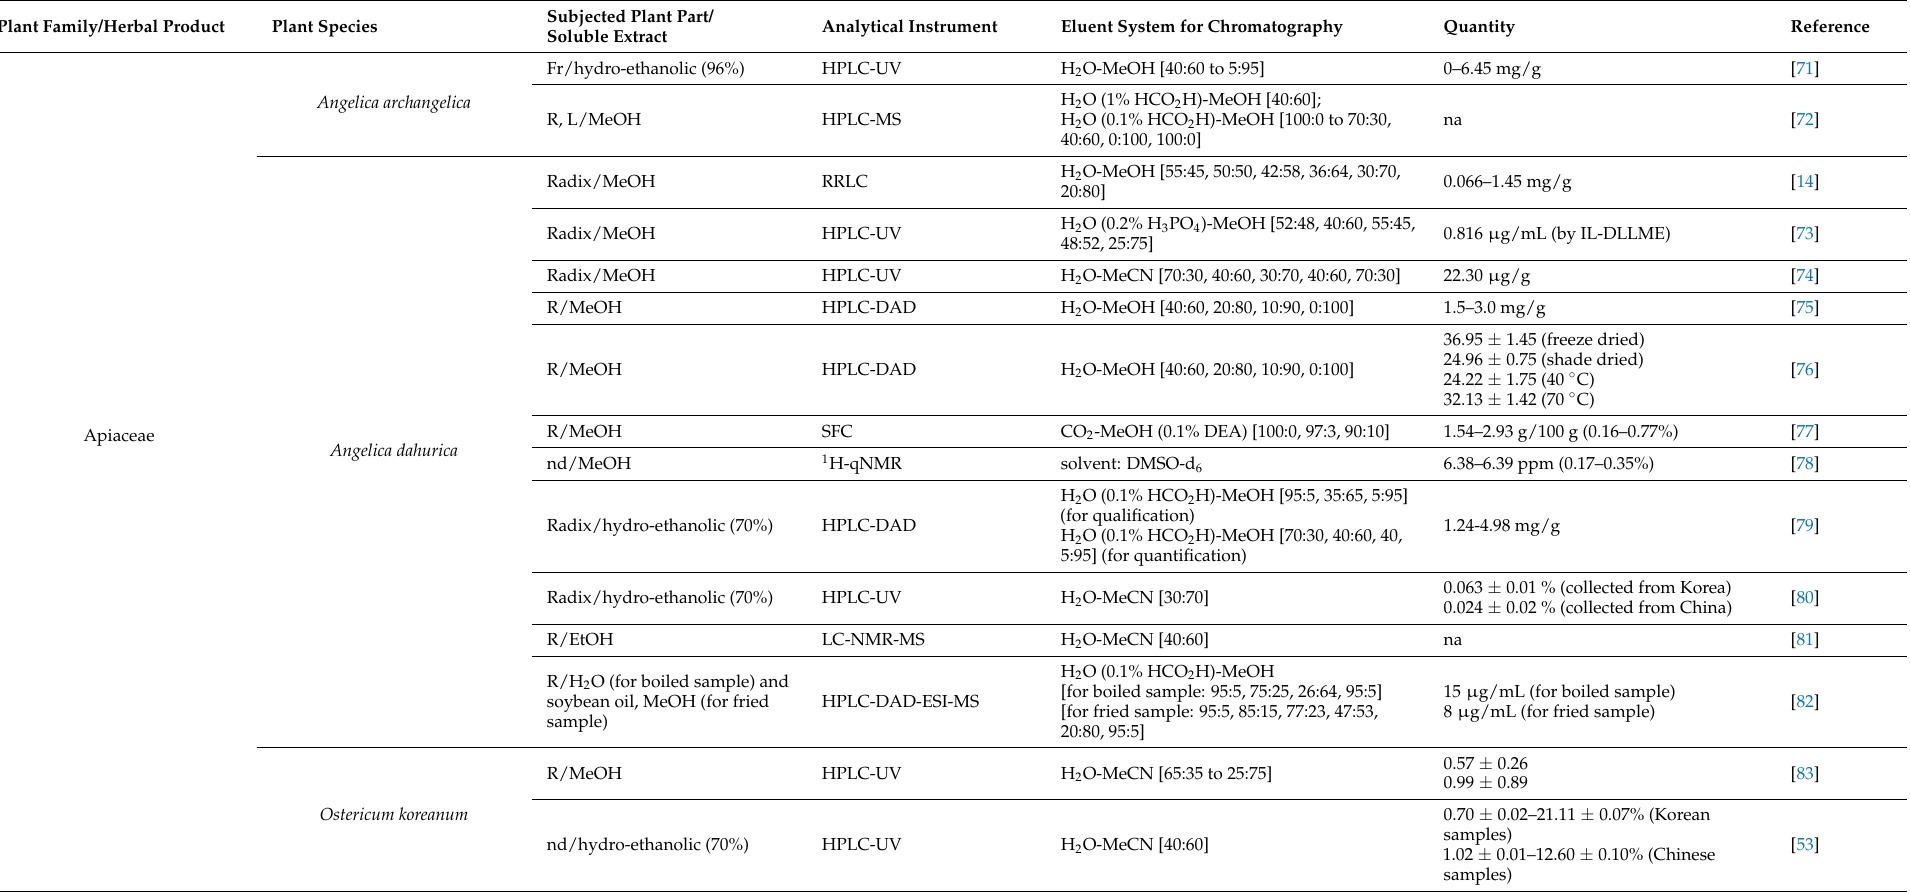
Table 2. Qualification and quantification fingerprint analysis of oxypeucedanin in different plant